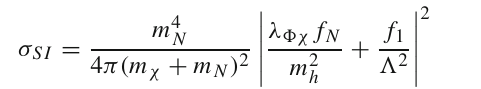
as well as dimension-6 operator O 1 , given below.